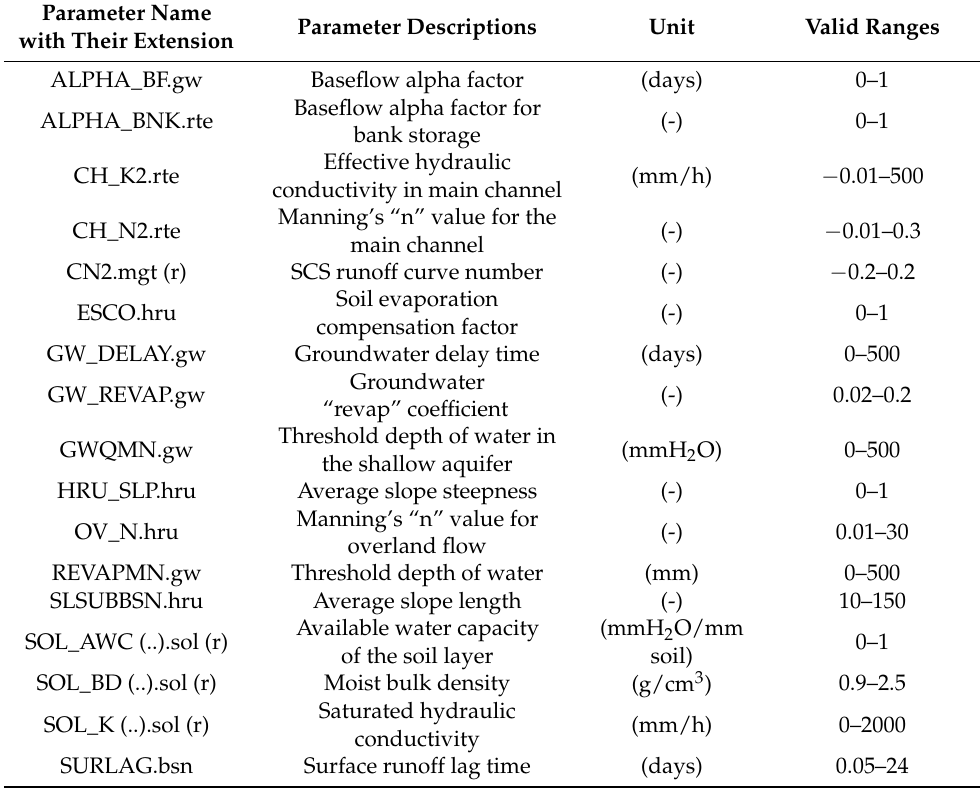
Table 1. SWAT model flow parameters used in the study